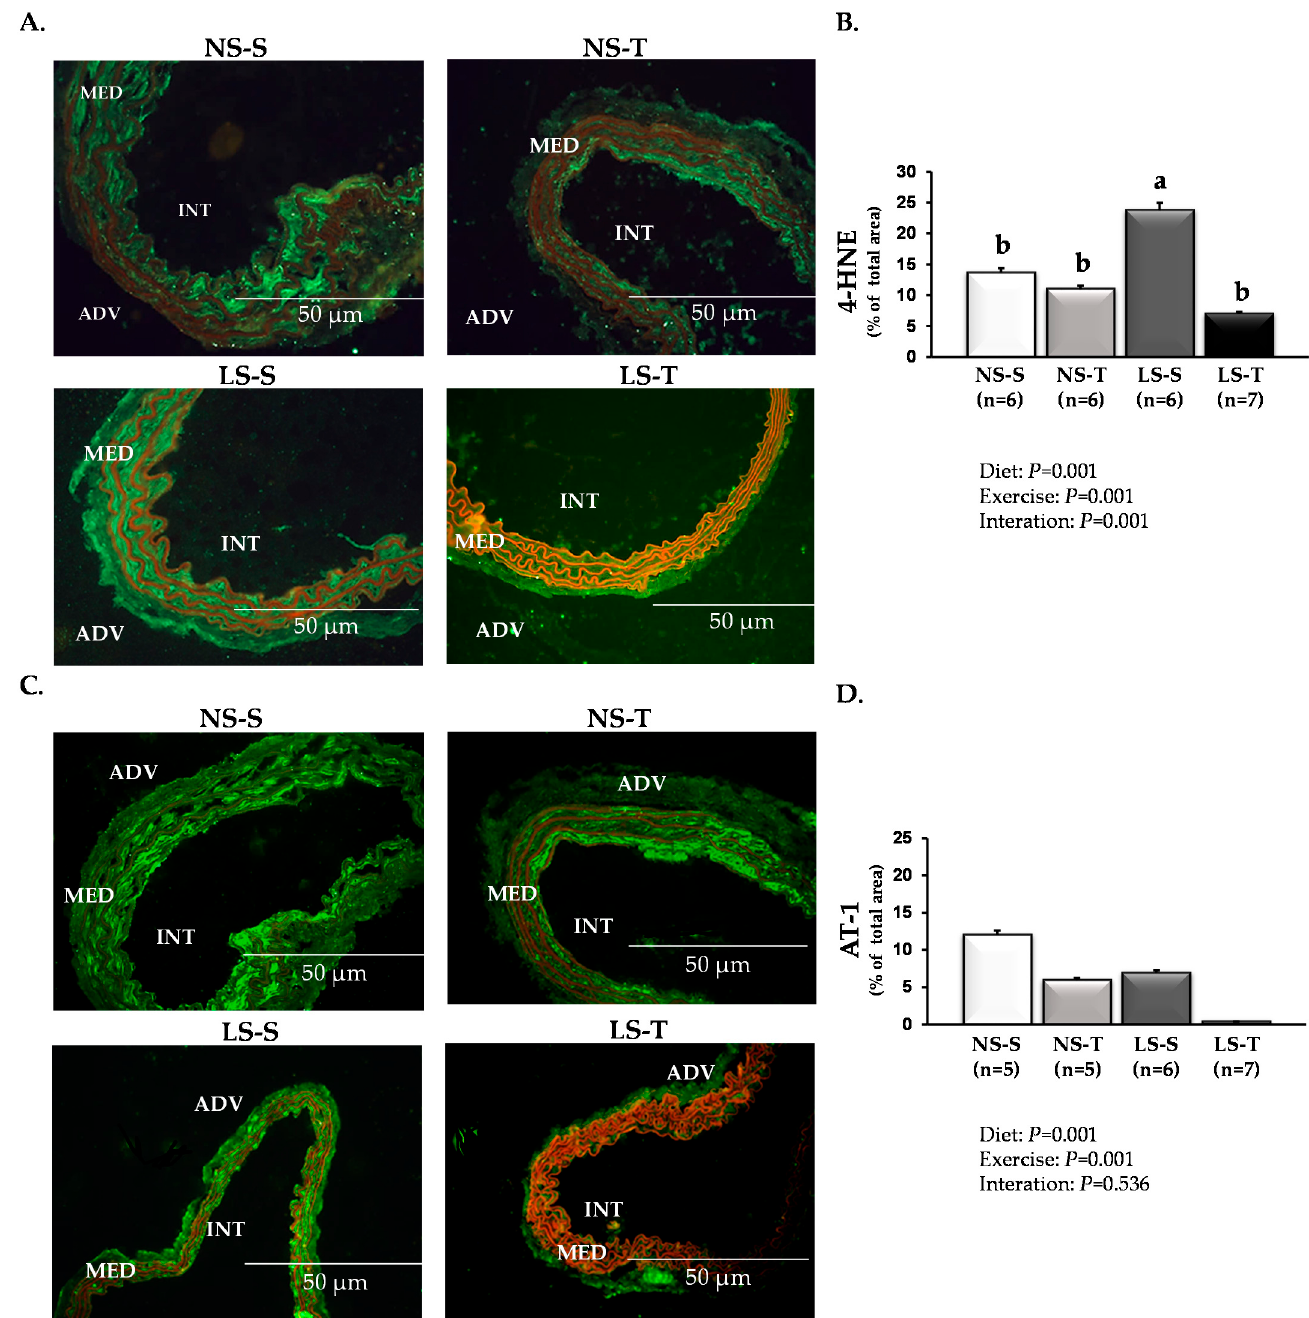
Figure 4. Vascular 4-hydroxynonenal (4-HNE) and angiotensin II type 1 receptor (AT1) receptor in LDLR KO mice fed either a normal-sodium (NS) or a low-sodium (LS) diet, trained (T) or sedentary (S), after 90 days. ( A ) Representative micrographs of immunofluorescence-stained 4-HNE in the brachiocephalic trunk. The green immunostaining indicates 4-HNE expression. ( B ) Histomorphometric analysis of immunofluorescence-stained 4-HNE. ( C ) Representative micrographs of immunofluorescence-stained AT1 receptor in the brachiocephalic trunk. The green immunostaining indicates AT1 receptor expression. ( D ) Histomorphometric analysis of immunofluorescence-stained AT1 receptor. ADV, adventitia; MED, media; INT, intima (400 × ). Red staining indicates counterstaining by 0.006% Evans blue dye. Two-way ANOVA test with two fixed factors (diet and exercise) and Tukey’s post-test were applied for comparisons among data. Results are expressed as mean ± standard deviation. Distinct letters represent differences among groups ( p < 0.05). n = number of